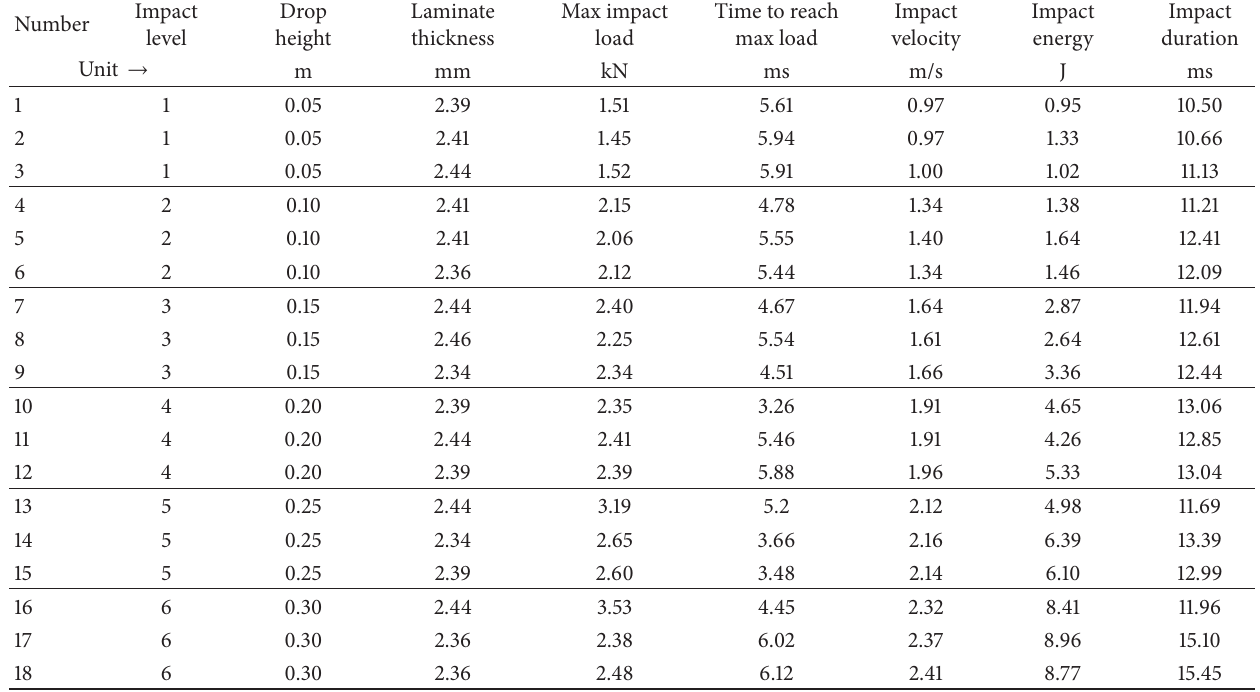
Table 4: AS4 Carbon Epoxy experimental